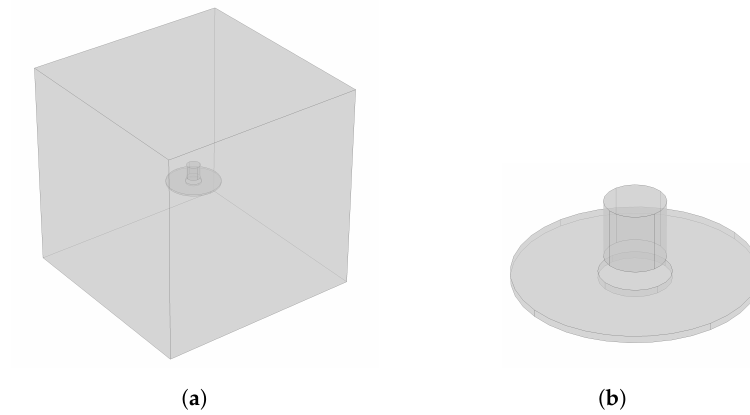
Figure 2. ( a ) Geometry of the finite element (FE) model with the 25.4 × 25.4 mm cylindrical magnet; ( b ) Close-up view of the geometry with the cylindrical magnet in the FE model.